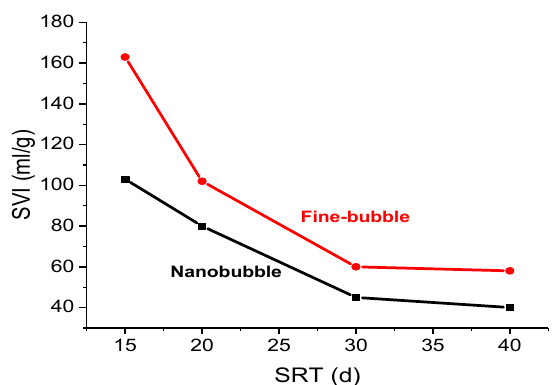
Fig. 6. Changes in Sludge Volume Index versus